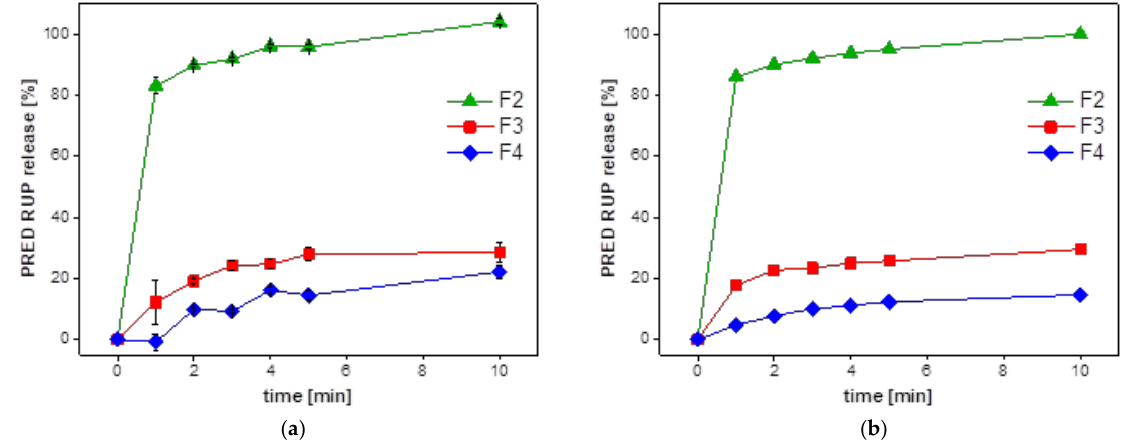
Figure 6. Electronic tongue prediction of RUP release: ( a ) results for the train set—points of dissolution curve presented as mean ± SD, n = 5; ( b ) results for independent test set, n = 1.